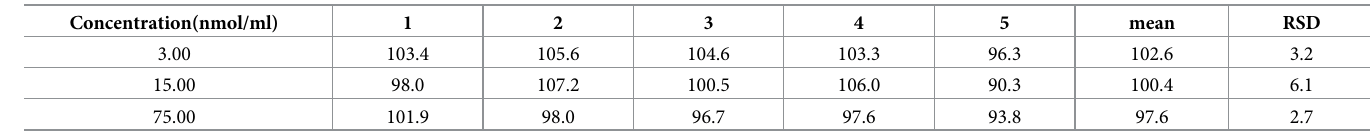
Table 3. 2.5-dimethylpyrrole standard recovery rate of hair digestion. Concentration(nmol/ml)